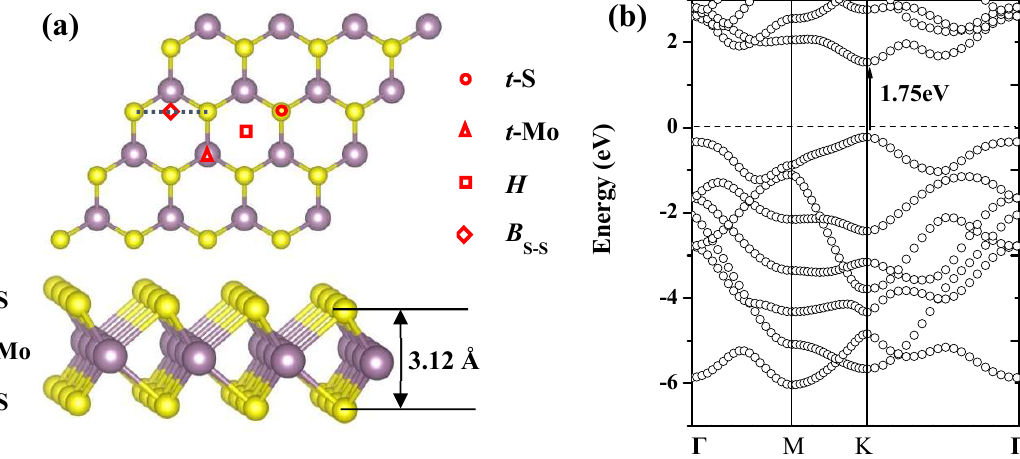
Figure 1. ( a ) Top and side views for the pristine MoS 2 monolayer (ML); S and Mo atoms are in yellow (small) and lavender (large) spheres, respectively. ( b ) Band structure of pristine MoS 2 monolayer and Fermi level is indicated by gray dashed line. Table 1. The structural parameters (Å) and calculated adsorption energies E A (eV) for Pd monomer adsorbed at four high-symmetry sites of MoS 2 monolayer.